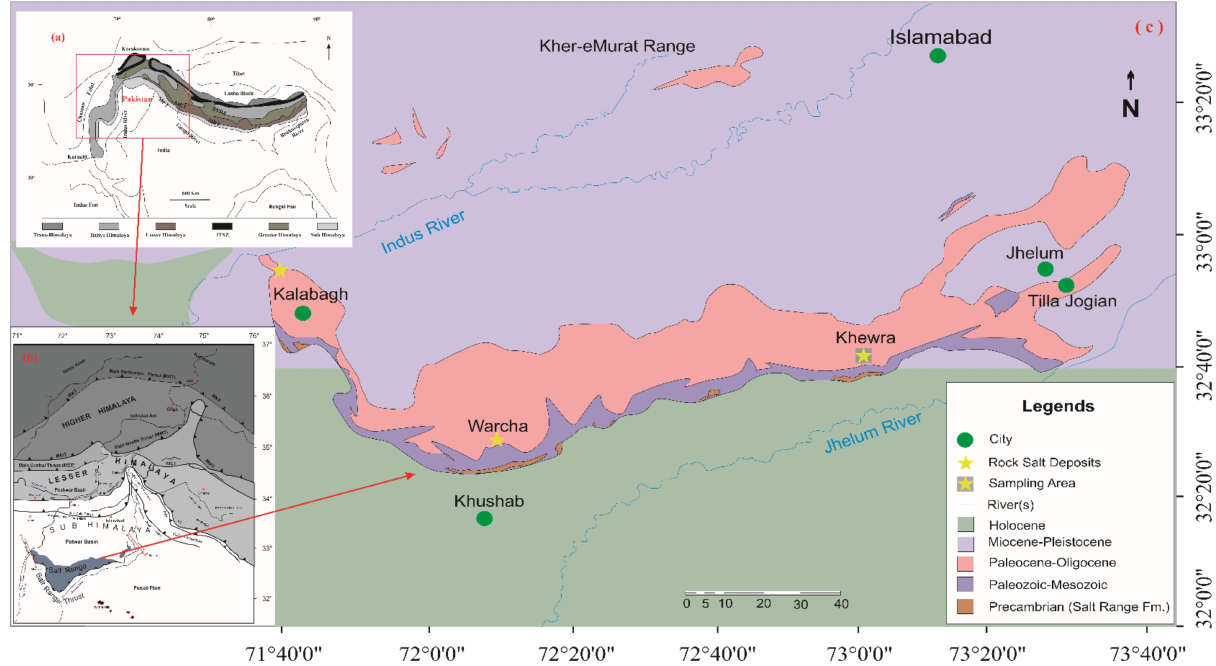
Figure 1. ( a ) Regional tectonic map showing the Himalayan Chain. ( b ) General Tectonic map of Northern Pakistan (modified after Kazmi and Rana 1982 [25]). ( c ) Geological map of the Salt Range and adjoining area (modified from Ghazi et al., 2015